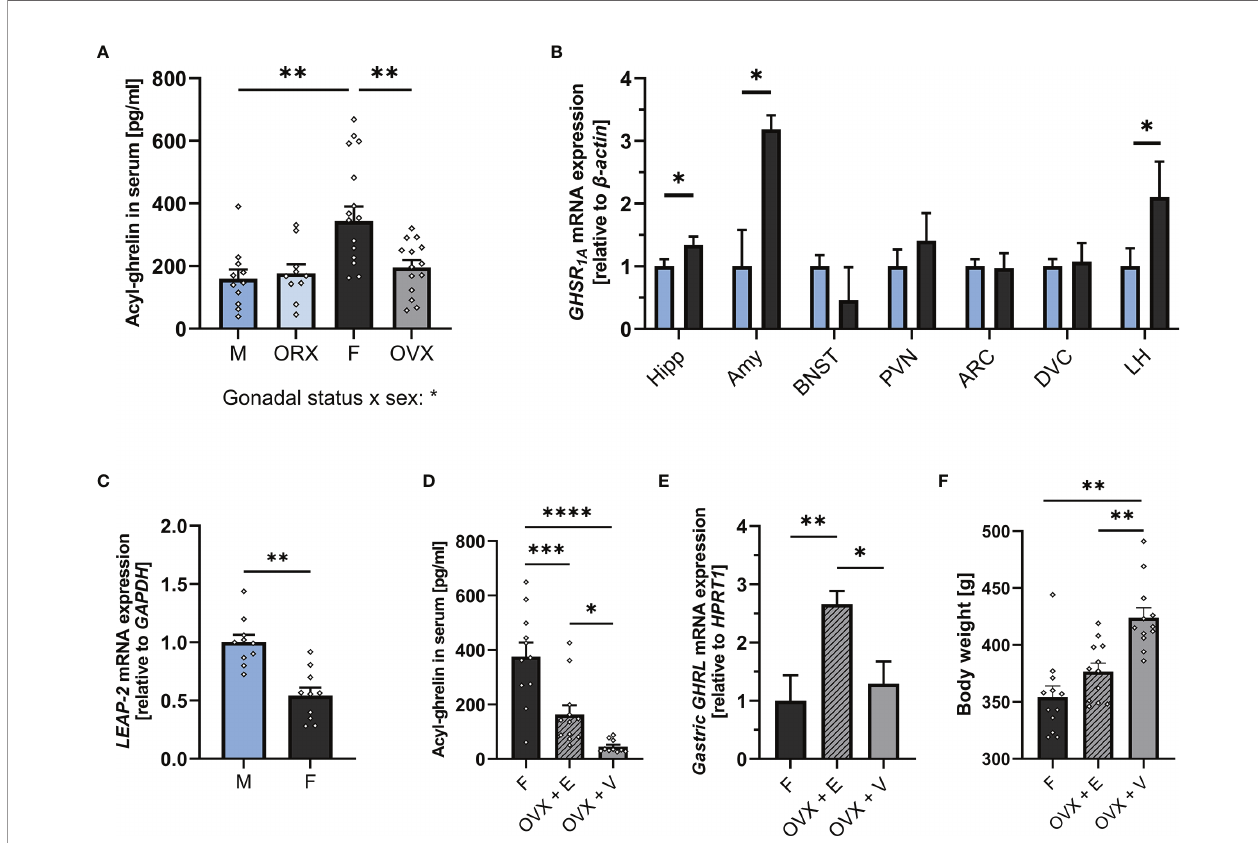
FIGURE 1 | The ghrelin axis at baseline is sexually dimorphic. Intact females (n = 17) had signi fi cantly higher levels of acyl-ghrelin in serum compared to males (n = 11) and OVX females (n = 14). Ghrelin levels in ORX males (n = 11) did not differ from intact males (A) . Females (n = 12) had higher GHSR 1A mRNA expression in the Hipp, Amy, and LH compared to males (n = 12) (B) . Males (n = 10) expressed signi fi cantly more hepatic LEAP-2 compared to females (n = 10) (C) . OVX females had lower serum ghrelin levels compared to intact females. Estradiol replacement was able to partially restore ghrelin levels (n = 11 per group) (D) . OVX females which received estradiol replacement had a higher expression of ghrelin in the stomach compared to intact females and OVX females with vehicle treatment (n = 11 per group) (E) . OVX rats that received vehicle only, had a signi fi cantly higher body weight on the day of tissue collection compared to OVX rats with estradiol replacement and intact females (n = 12 per group) (F) . All data are presented as mean ± SEM. * p < 0.05, ** p < 0.01, *** p < 0.001, **** p < 0.0001 compared with respective controls. ORX, orchiectomized; OVX, ovariectomized; GHSR 1A , ghrelin receptor; Hipp, Hippocampus; Amy, Amygdala; BNST, Bed nucleus of stria terminalis; PVN, paraventricular nucleus; ARC, arcuate nucleus; DVC, dorso-vagal complex; LH, lateral hypothalamus; LEAP-2, liver-expressed antimicrobial peptide 2; GAPDH, glyceraldehyde-3-phosphate dehydrogenase (housekeeping gene); OVX + V, ovariectomized females with vehicle treatment; OVX + E, ovariectomized females with estradiol replacement. GHRL, ghrelin